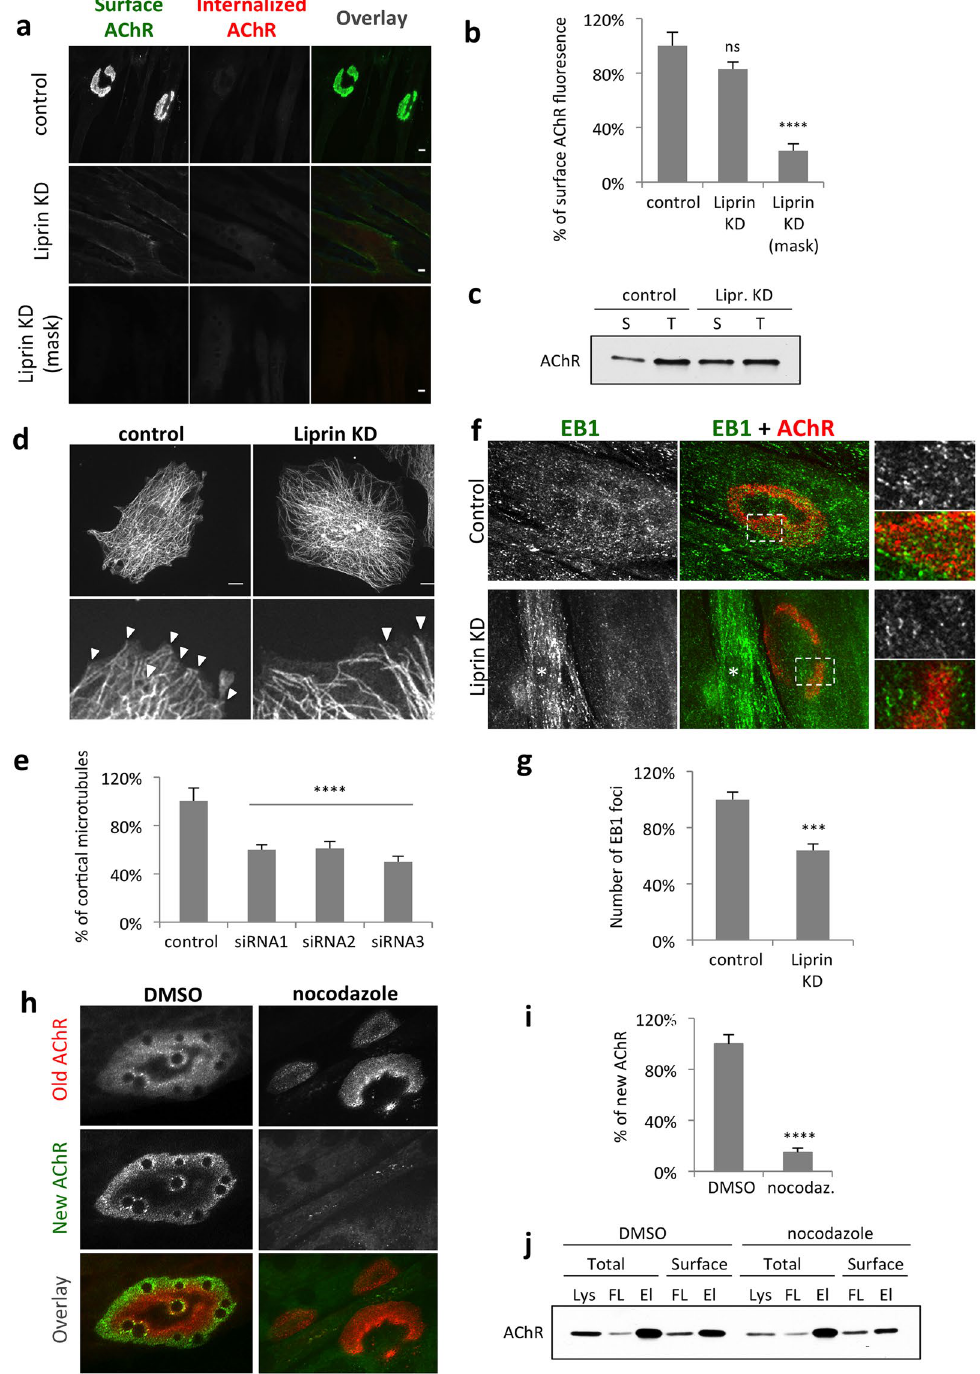
Figure 5. Liprin- α -1 regulates clustering of AChRs by organizing microtubules. ( a – c ) C2C12 myotubes depleted of liprin- α -1 have substantial amounts of surface AChR. ( a ) Surface AChR (green) were stained with Alexa-488-BTX and internal AChR were labelled with Alexa-555-BTX. Lower panel shows control experiment for labelling specificity of the Alexa-488-BTX staining shown in the middle panel. Unlabelled BTX was applied to live cells prior to Alexa-488-BTX labelling to mask BTX binding sites on AChR. ( b ) Fluorescence intensity quantification of surface AChR labelling, values normalized to control. ( c ) Analysis of surface AChRs in liprin- α -1-depleted myotubes by AChR precipitation and Western blotting. S-surface and T-total AChR precipitates. ( d , e ) Liprin- α -1 knockdown reduces the number of plasma membrane-attached microtubules in myoblasts. ( d ) Cells were transfected with indicated siRNAs and microtubules were visualized with anti- α -tubulin antibody. Lower panel represents higher magnifications of areas in the upper panels. Arrows indicate examples of microtubules in contact with cell surface. ( e ) Quantification of cell surface-attached microtubules per micrometre of the cell edge from 60 cells in three independent experiments. ( f , g ) Liprin- α -1 knockdown